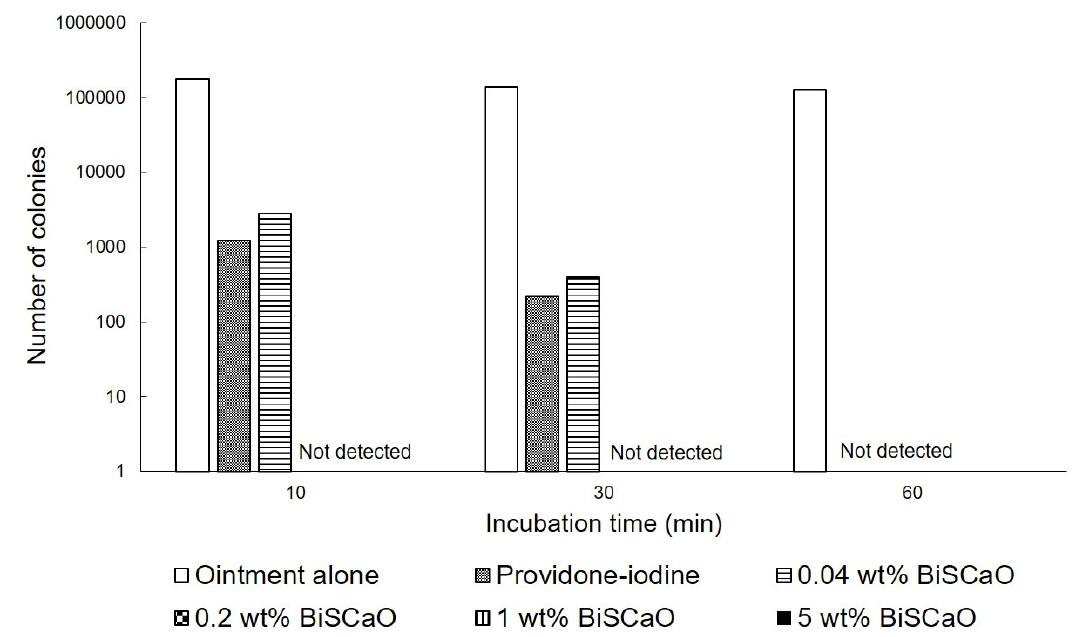
Figure 1. In vitro bactericidal activity of each ointment. P. aeruginosa was exposed to 0.04, 0.2, 1 and 5 wt% BiSCaO ointments, 3 wt% providone iodine ointment, or control ointment-coated plates and incubated for 5, 10, 20 and 30 min at room temperature. The bacterial colonies were counted to measure the minimal bactericidal concentration of each disinfectant ( n = 6).